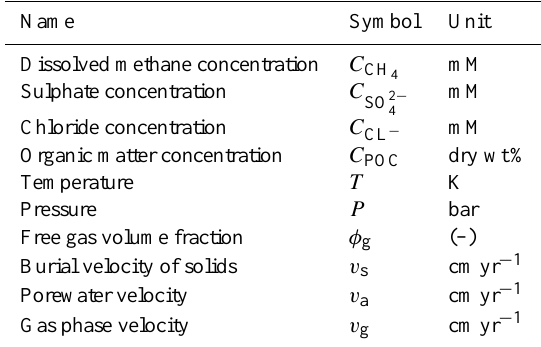
Table 1. Time dependent model